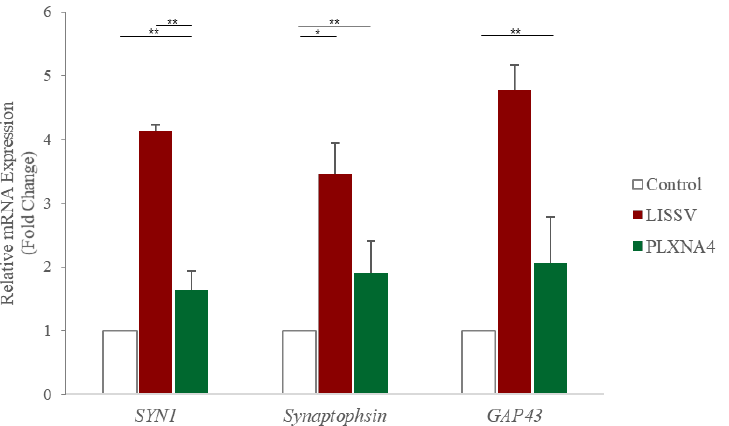
Figure 14. Expression of presynaptic vesicle protein-associated genes in human umbilical-cord-